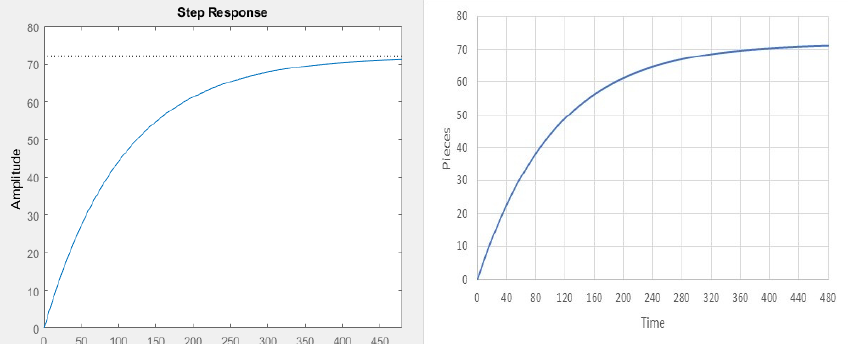
Figure 6. Output process of weaving, blocks and Stella.